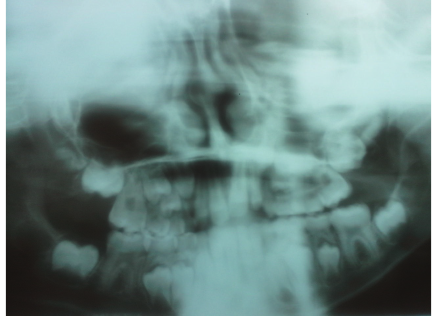
Figure 1: Facial characteristics of the patient: facial asymmetry and bilateral malformations of the ear.